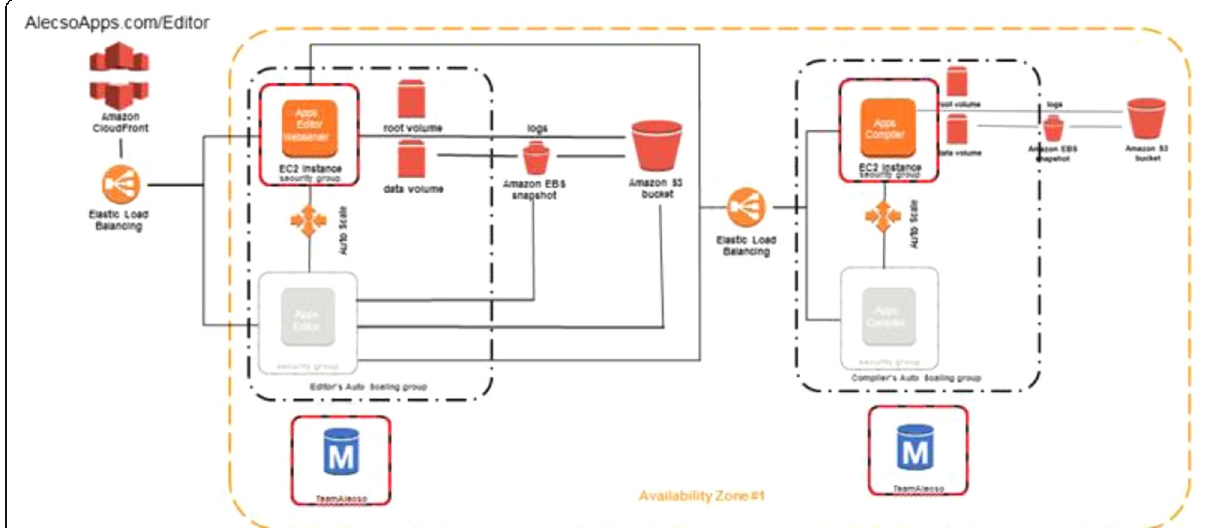
Fig. 5 ALECSO Apps Editor: Cloud